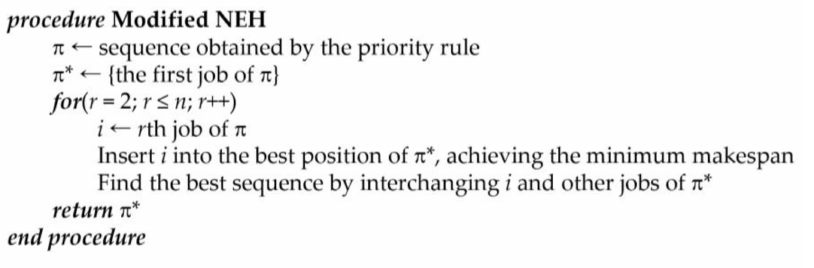
Figure 2. Modified NEH algorithm